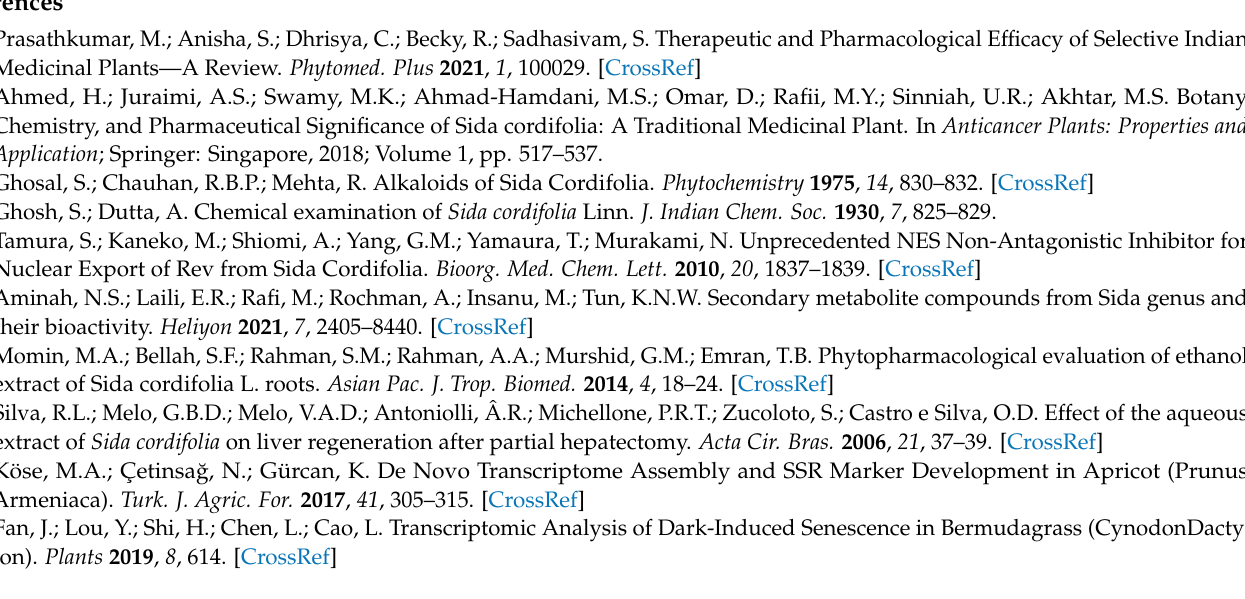
Sida cordifolia. Figure S2: Gene ontology classification of Sida cordifolia . Figure S3: KEGG pathway analysis based on the metabolism pathways in Sida cordifolia . Figure S4: KEGG pathway analysis of phenylpropanoid biosynthesis. Figure S5: KEGG pathway analysis of flavonoid biosynthesis. Figure S6: SSR identification from root transcriptome of Sida cordifolia. Table S1: List of genes selected to validate gene expression and their primer